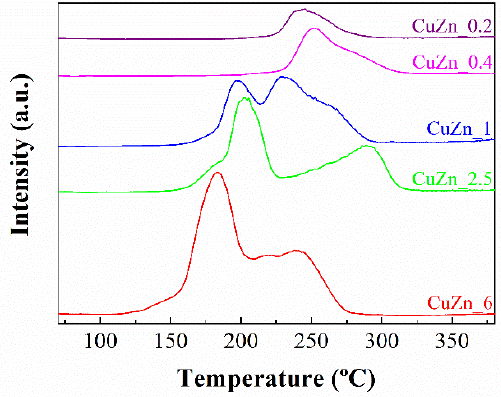
Figure 3. H 2 -TPR profiles of the mixed metal oxides obtained after calcination of LDHs.